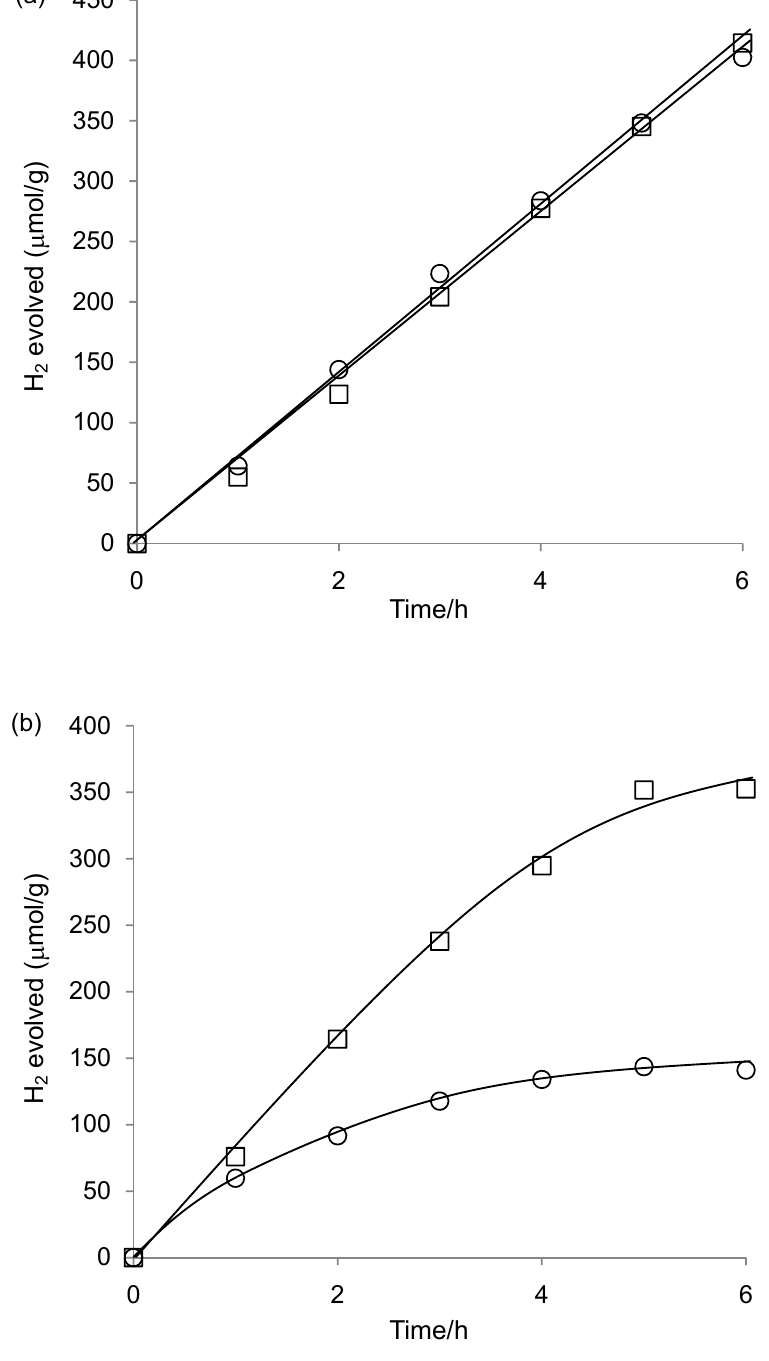
Figure 8. Time course for H evolution catalyzed by (a) 2 -Pt-TiO 2 2 -Pt-TiO (0.19) under light irradiation ( ≥ 400 nm). The first and second runs are 2 represented by circles ( ○ ) and squares ( □ ), respectively. Reaction conditions: see Table